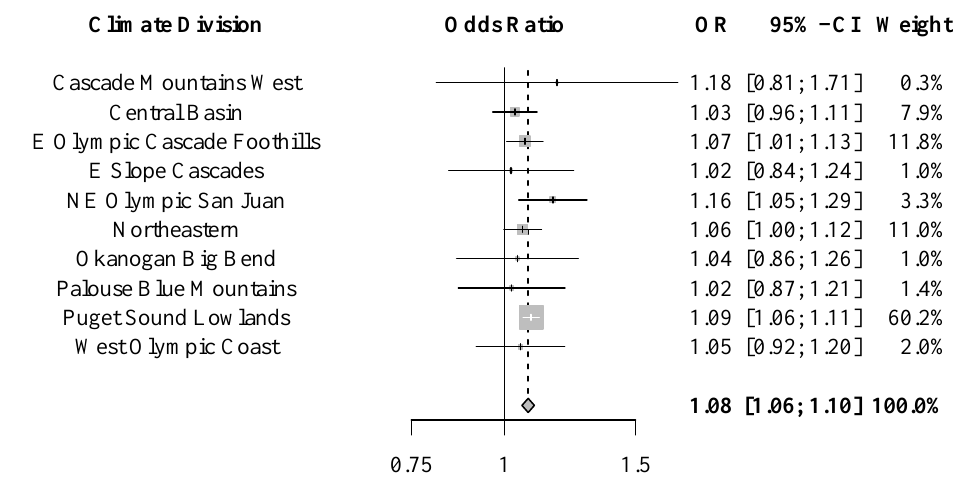
Figure 3. Odds ratio and 95% CI of mortality, comparing the 99th and 50th percentiles of humidex. The results for effect modification by age, sex, and race/ethnicity are given in Table 3 and by both age and cause of death in Table 4. All values represent ORs pooled